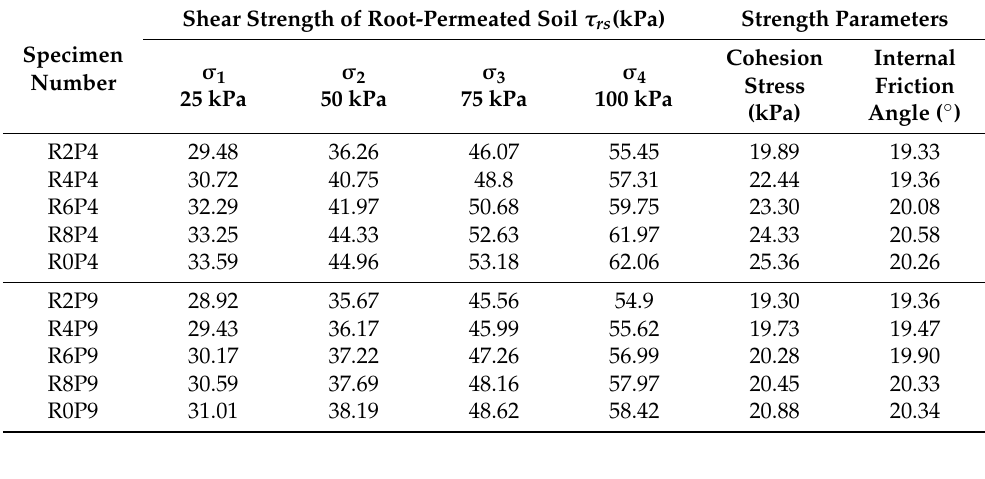
Table 7. Shear strength and strength parameters of root-bearing soil in the direct shear test.